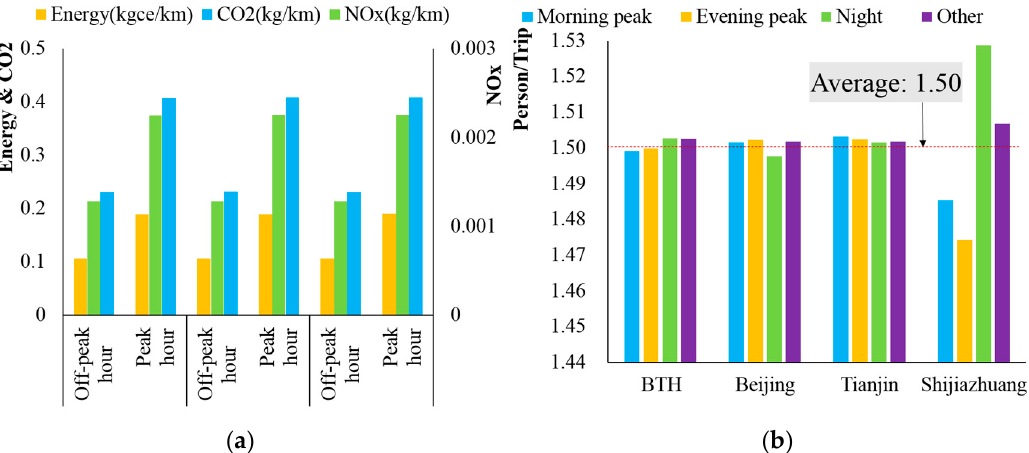
Figure 8. Environmental impact and guest number per unit. Multiple panels: ( a ) Energy consumption and emission per kilometer; ( b ) Average guest number per order.